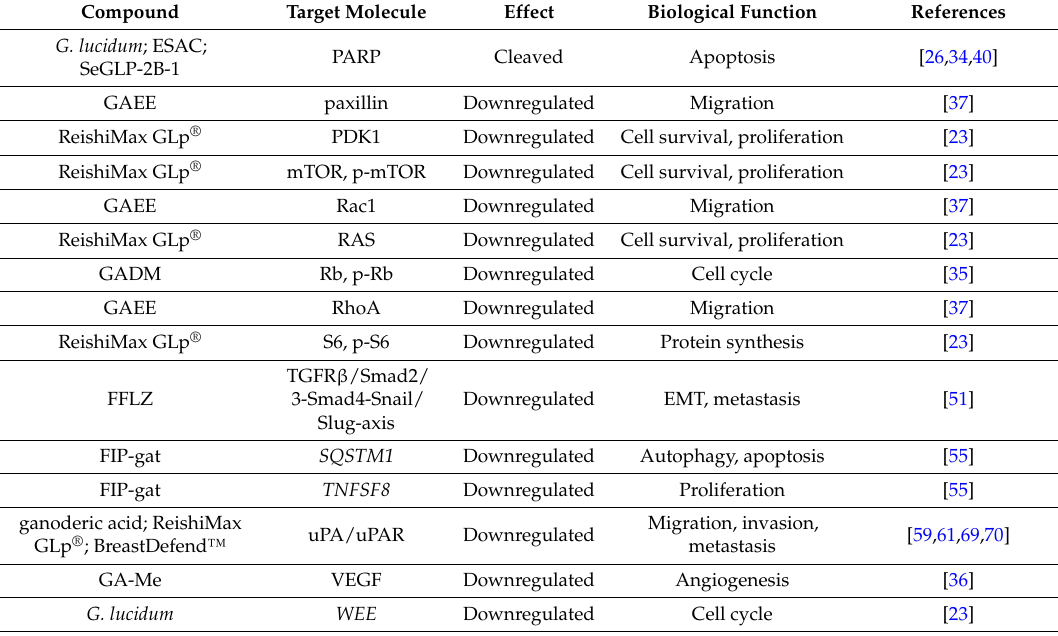
Table 3. Anti-breast-cancer mechanisms of Ganoderma spp. FIP, fungal immunomodulatory protein; ESAC, ethanol-soluble and acidic